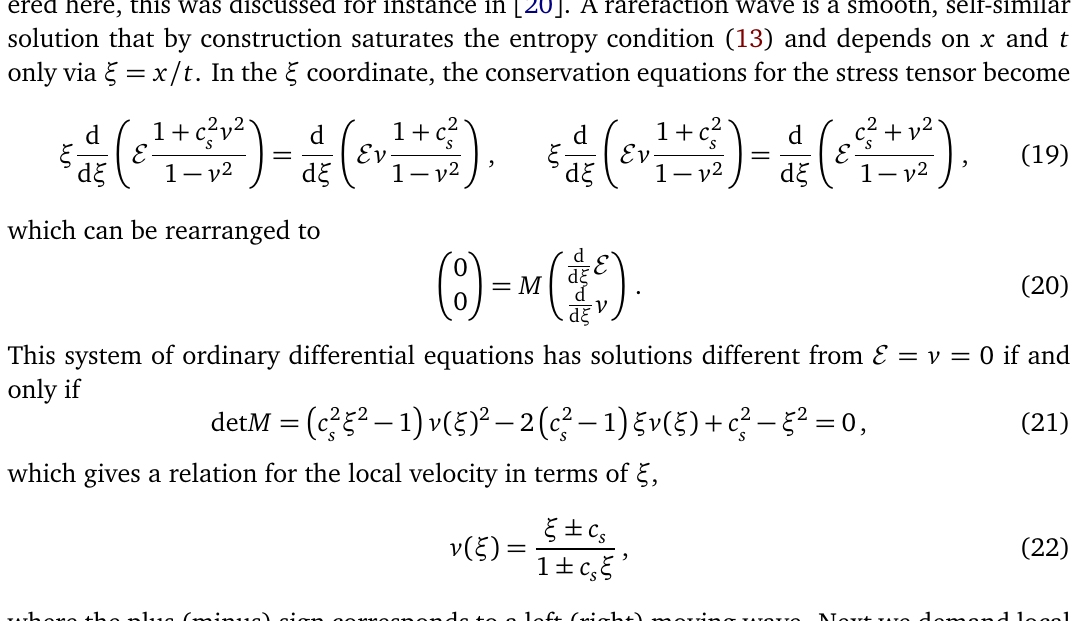
Figure 2: (left) The velocities of the steady state flow ( v moving shock velocities v according to Eqn. (11). (right) Change in entropy across the left and right moving shock waves, as function of χ = to the right-moving shock. The normalisation factor is motivated by